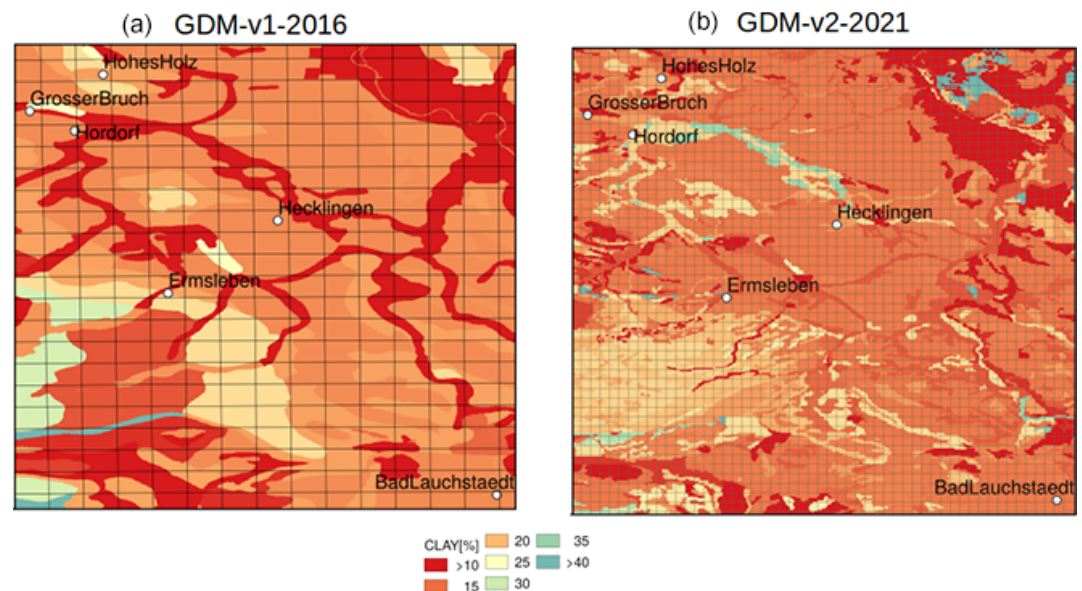
Figure 1. Average derived clay [%] over the soil column from the BUEK1000 soil dataset used in the GDM-v1-2016 model setup (a) versus the BUEK200 soil dataset used in the GDM-v2-2021 model setup (b) . The grid shows the respective modeling resolution L1, at which the hydrological processes are simulated (see Table 1). Both setups are projected in WGS 84